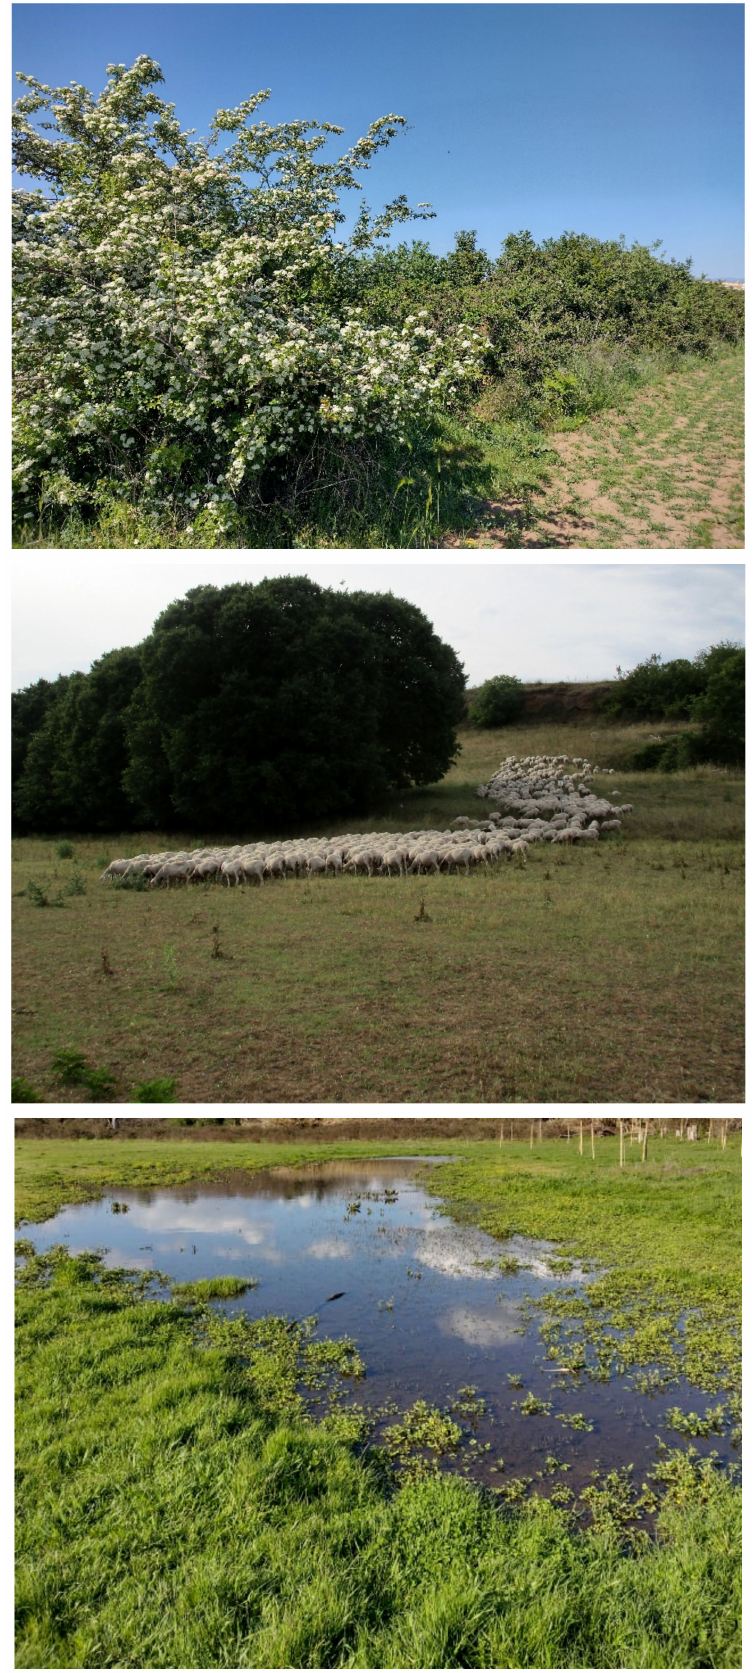
Figure 12. Landscape elements of Appia Antica Regional Park: patches. Shrubs adjacent to crops (top photo); pasture (central photo); humid meadow (bottom